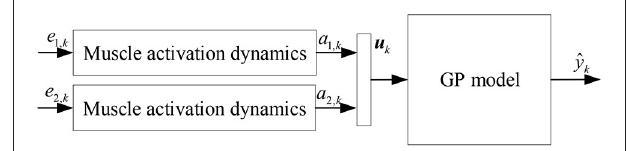
FIGURE 2 | Joint angle prediction based on Gaussian process